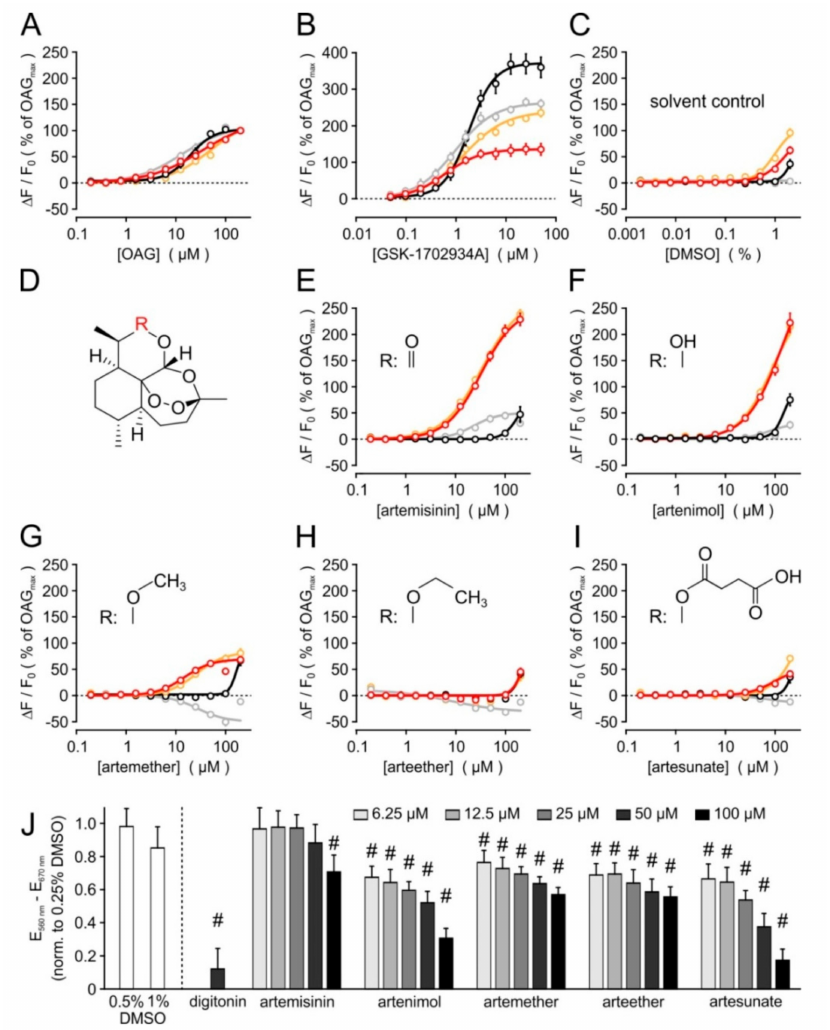
Figure 1. Concentration response analysis of known and novel TRPC3 / TRPC6 / TRPC7 activators, and cytotoxicity analysis. The potency and e ffi cacy of various compounds to elicit a [Ca 2 + ] i response was tested in fluo-4-loaded cell suspensions, applying HEK293 cells that were stably transfected with cDNA plasmids encoding either TRPC3 (red symbols and lines), TRPC6 (black), or TRPC7 (grey). HEK cells that form TRPC3:TRPC6 heteromeric complexes by stably co-expressing TRPC3 and TRPC6 are also included (orange). Concentration–response curves for the indicated known activators ( A , B ), and for artemisinin and related compounds ( E – I ) are shown. Since 10 mM stock solutions were prepared for all compounds, the corresponding solvent control ( C ) applies to all other data. The common substructure for artemisinin-related compounds ( D ) with the respective substituents R (insets in E – I ) are